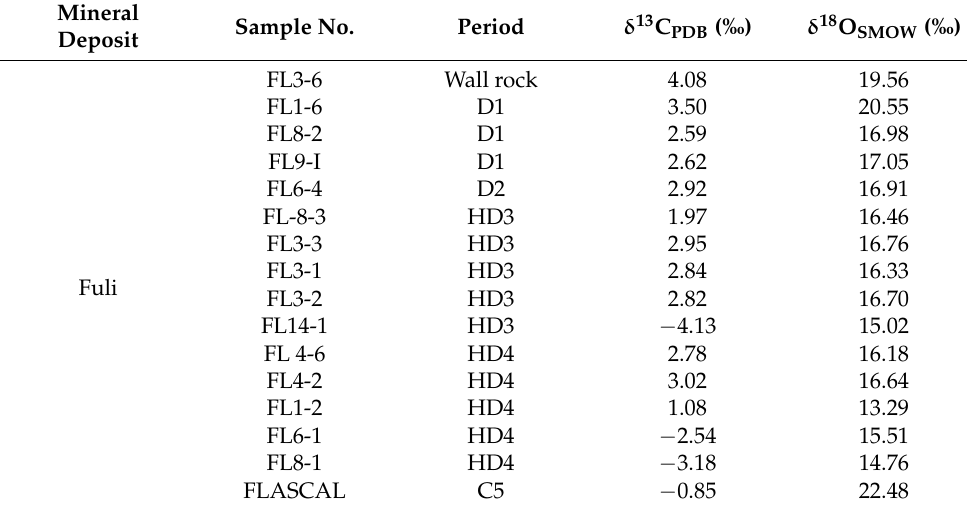
Table 2. C and O isotopic compositions of dolomite in the Fuli Pb-Zn deposit. Mineral Sample No. Period δ 13 C PDB (‰) δ 18 O SMOW (‰) Deposit